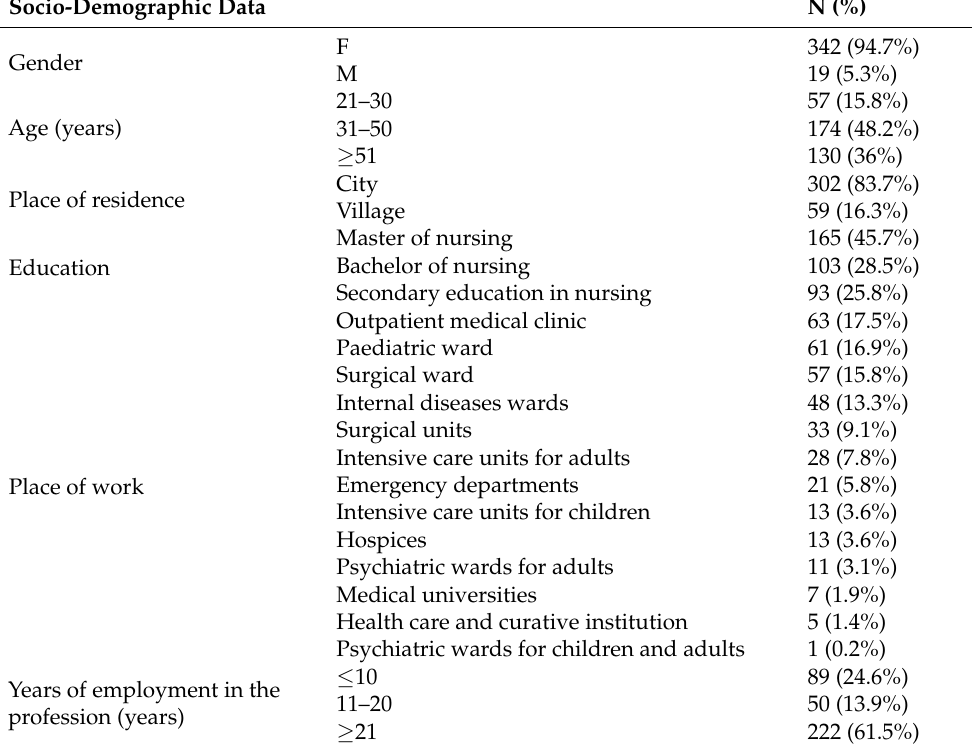
Table 1. Characteristics of the